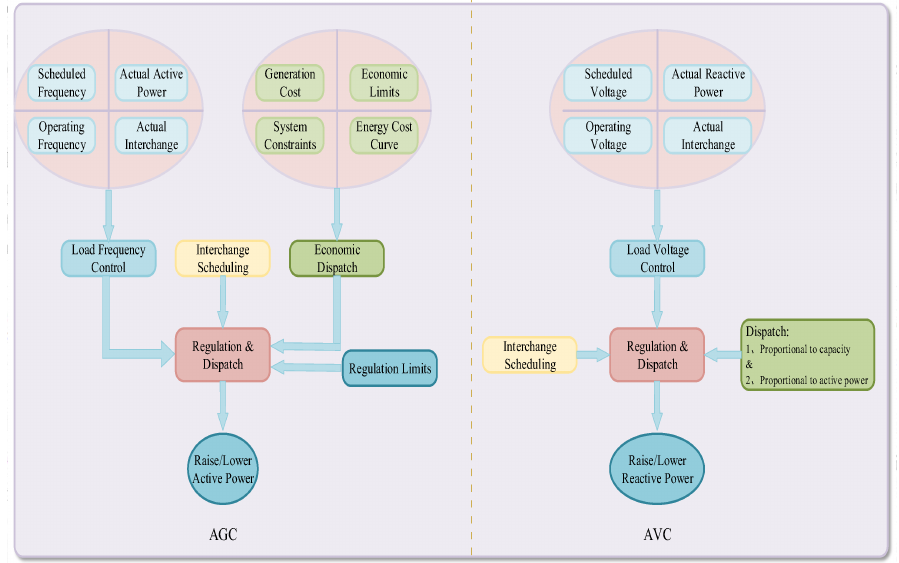
Figure 1. The workflow of secondary AGC and